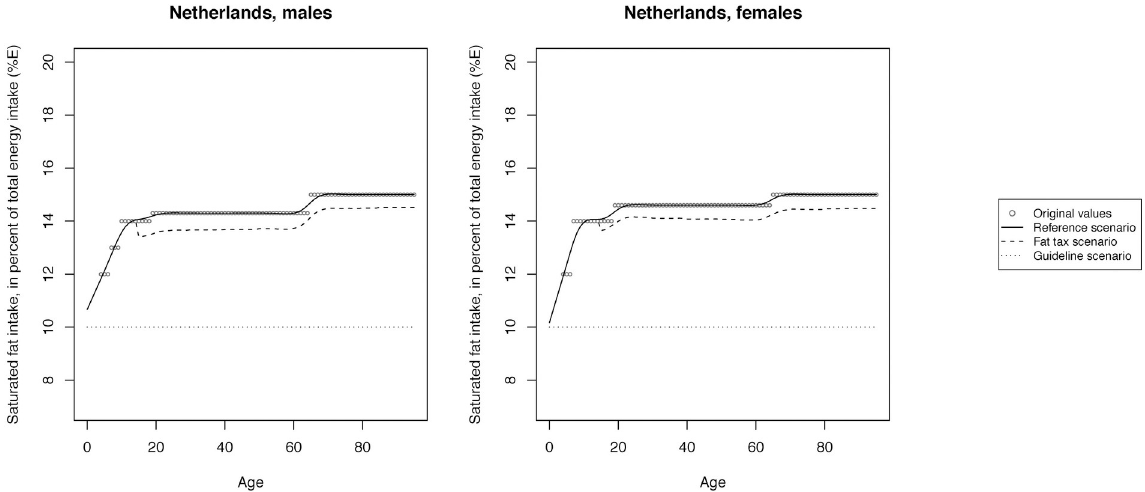
Fig 4. Mean saturated fat intake across reference, fat tax and guideline scenario in the